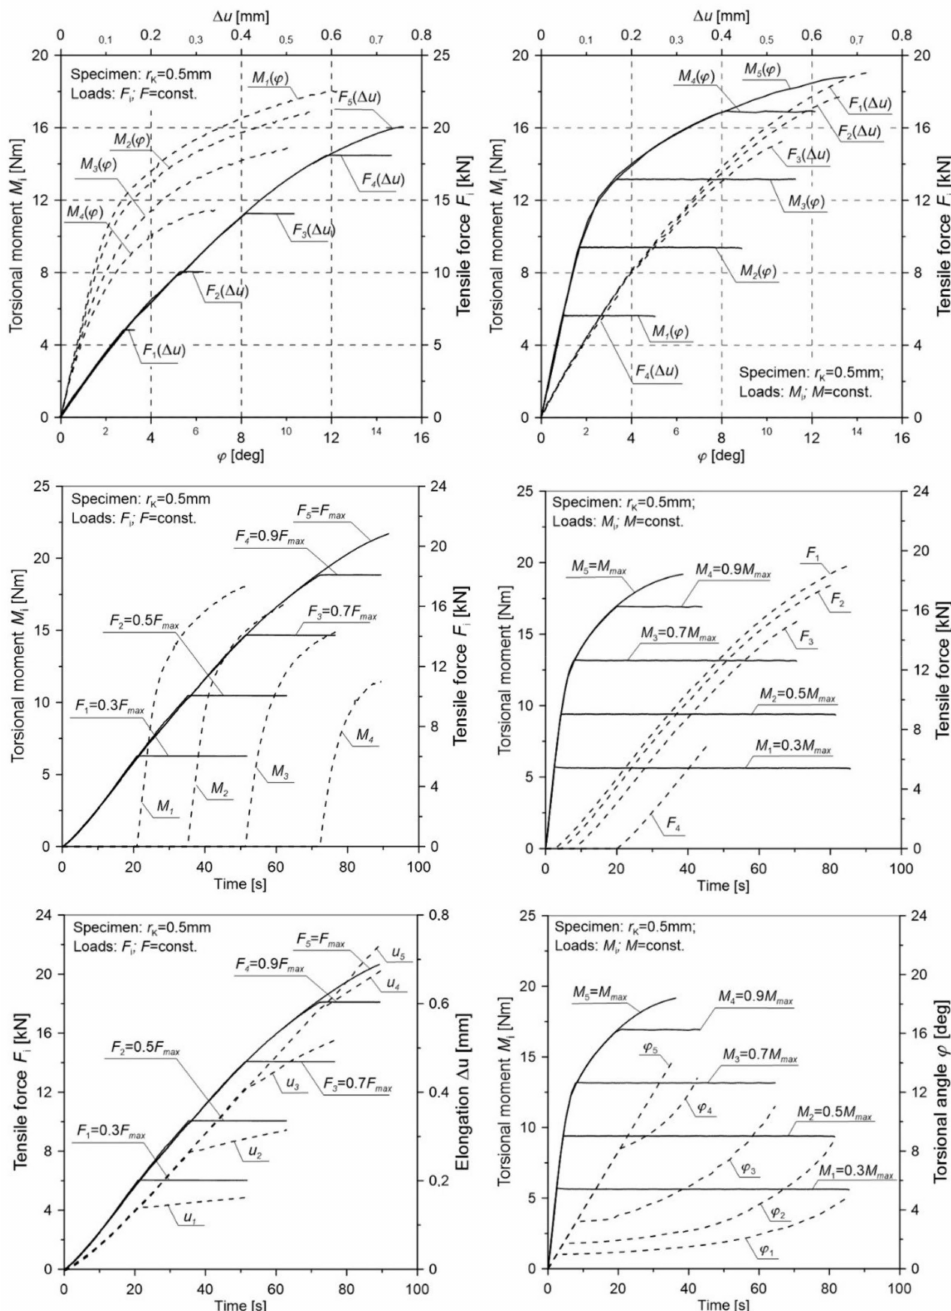
Figure 8. The distribution of the tensile force, torsional moment, elongation, and torsional angle of the gauge length of a notched specimen with a radius r K = 0.5 mm for various load